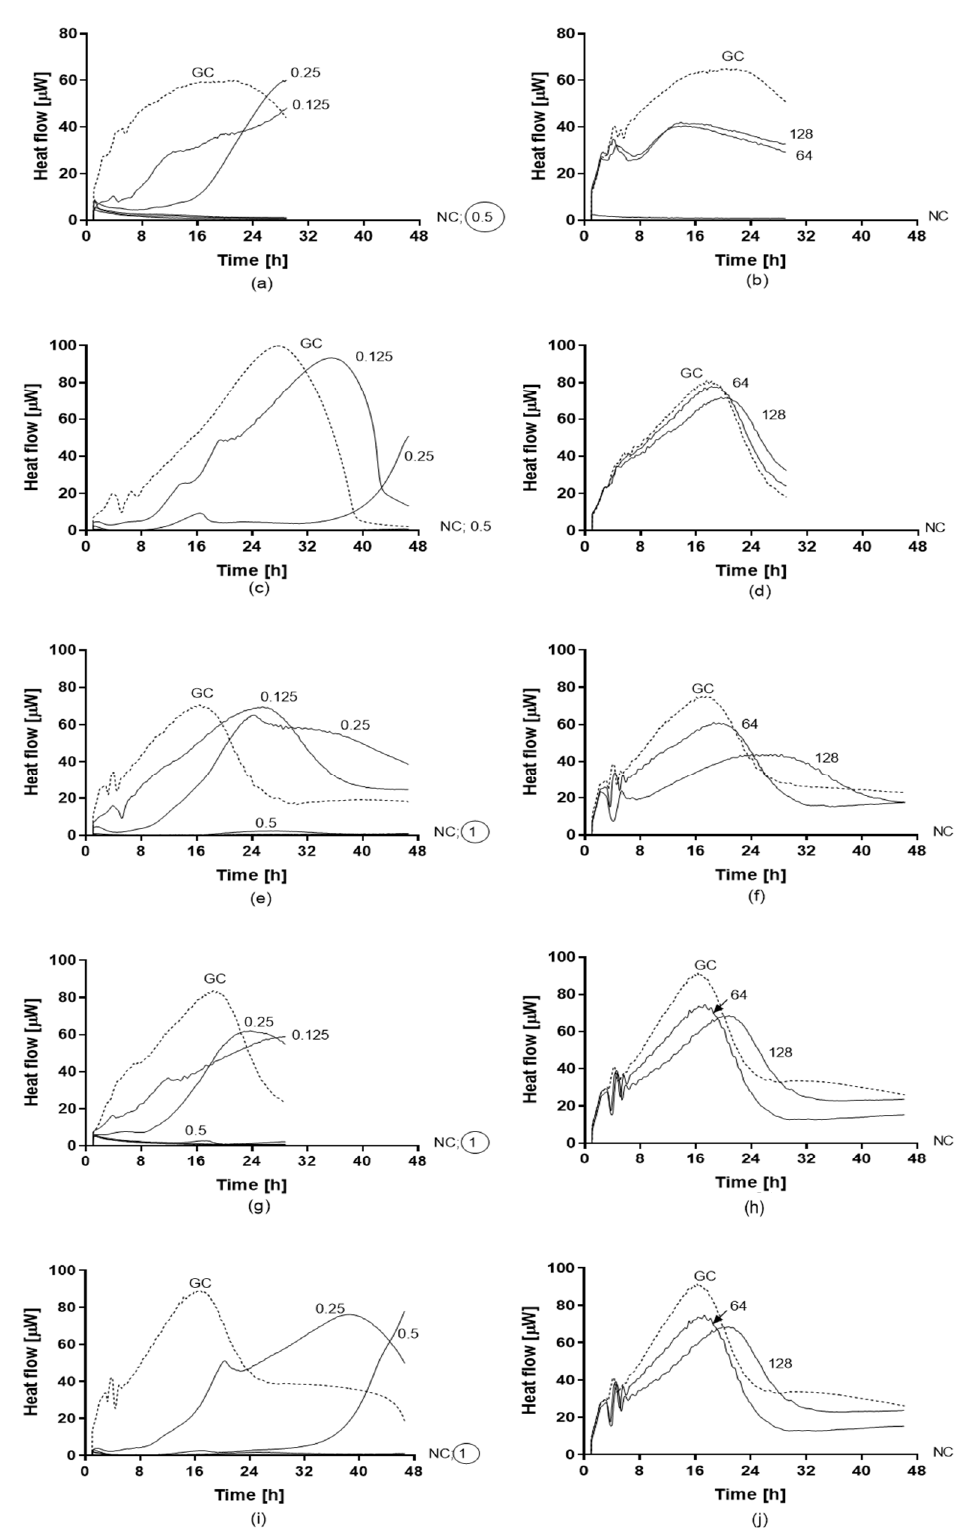
Figure 5. Heat flow curves generated by planktonic strains of C. auris CBS14916 ( a , b ), C. auris 10051257 ( c , d ), C. auris 10051259 ( e , f ), C. auris 10051266 ( g , h ), and C. auris 10051297 ( i , j ) in the presence of different concentrations of amphotericin B ( a , c , e , g ) and fluconazole ( b , d , f , h ). Numbers indicate the antifungal concentrations (µg/mL). GC: growth control (without antifungal agent). MHIC is defined as the lowest antifungal concentration that inhibited the yeast growth-related heat production during 24–48 h incubation in the microcalorimeter. The circled value denotes the minimum fungicidal concentration (MFC).